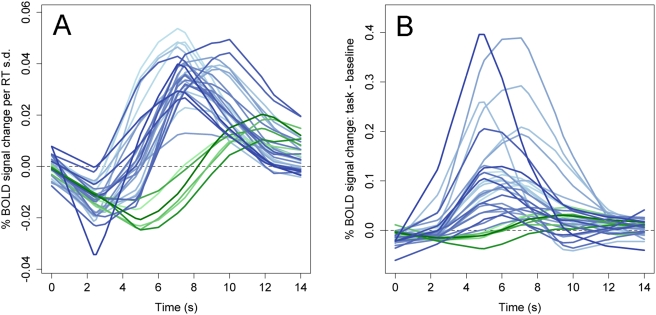
Mean RT and task-related time courses in all ANOVA ROIs.Each time course represents the time course of RT-related activation (A) or task-related activation (B) in a single region, averaged over all five samples. Blue: gray matter ROIs; green: white matter ROIs.